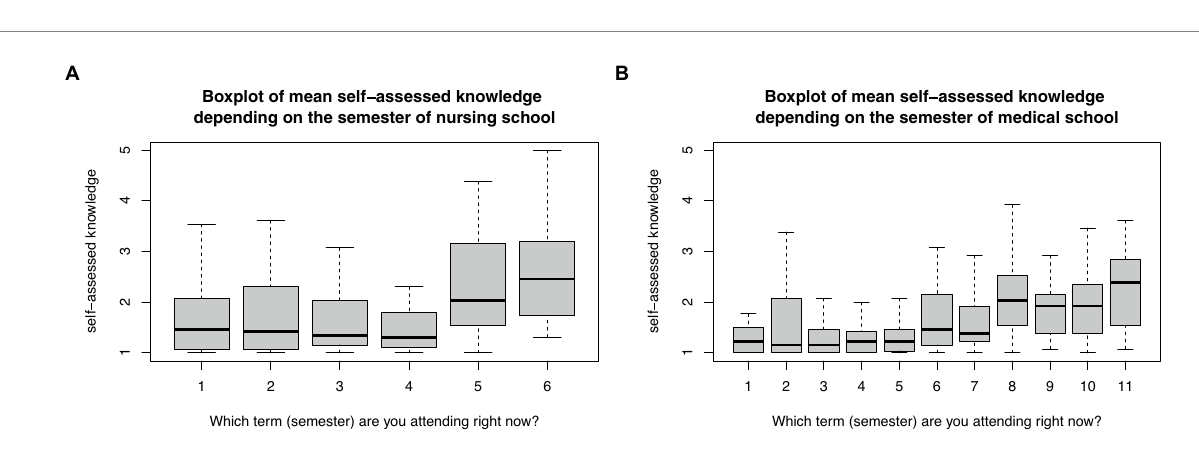
(Table 3) and as a difference in mean self-assessed knowledge ( t -test, p < 0.001; Figure 6).